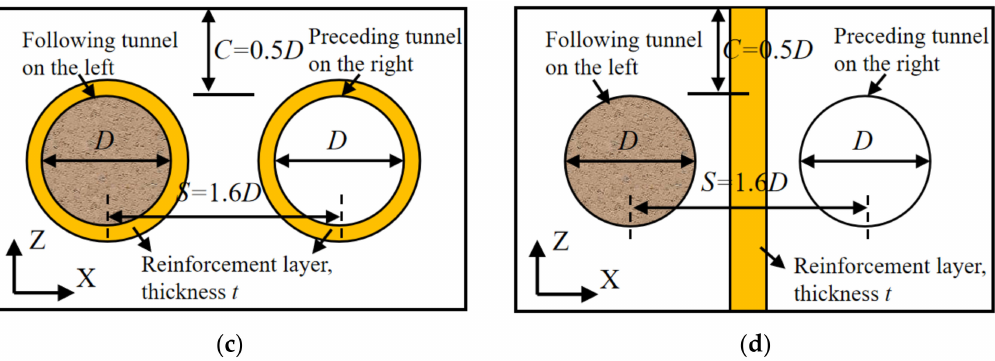
Figure 2. Sketch of reinforcement strategies for paralleled twin tunnels: ( a ) RR; ( b ) LR; ( c ) TR; ( d ) CR.